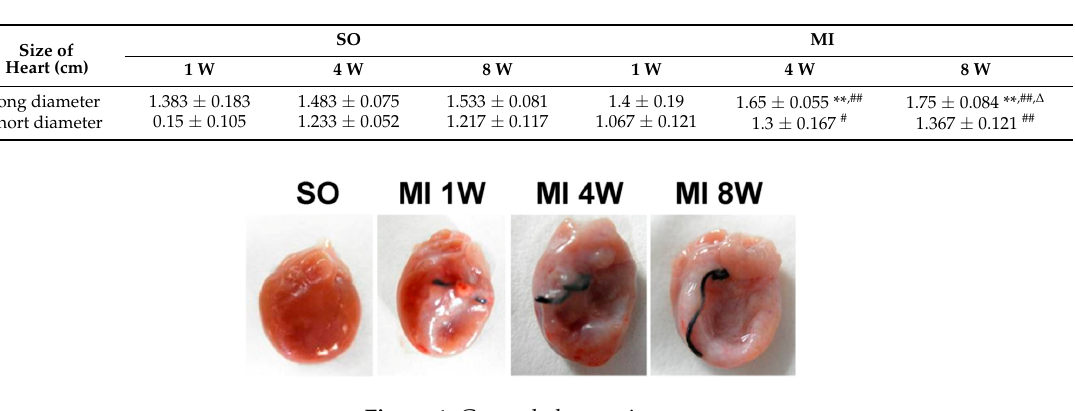
Table 1. The sizes of the hearts of rats. The long diameter and short diameter of hearts were measured using a vernier caliper. ** p < 0.01, compared with the sham-operated (SO) group. # p < 0.05, ## p < 0.01, compared with the one-week myocardial infarction (MI) group. ∆ p < 0.05 compared with the four-week MI group.